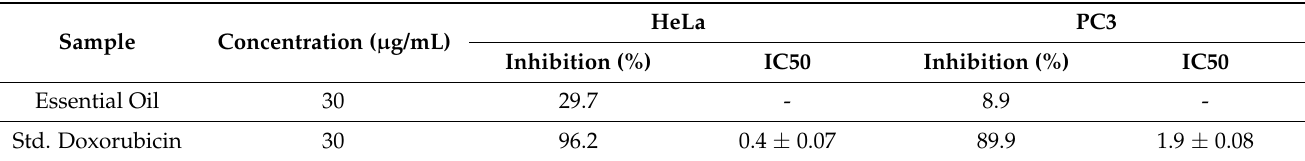
Table 4. MTT assay for OB essential oil.